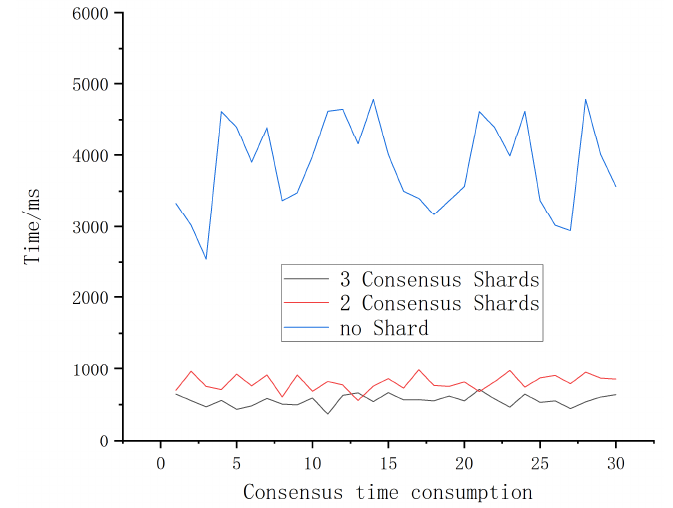
Figure 13. Consensus time consumption.